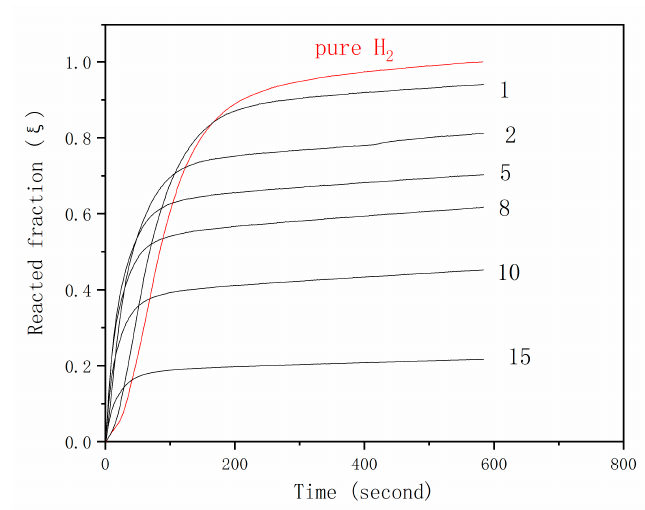
Figure 5. Hydrogen absorption kinetic curves of TiFe 0.86 Mn 0.07 Co 0.07 at 3 MPa of pure H 2 and H 2 containing 250 ppm of O 2 at 298